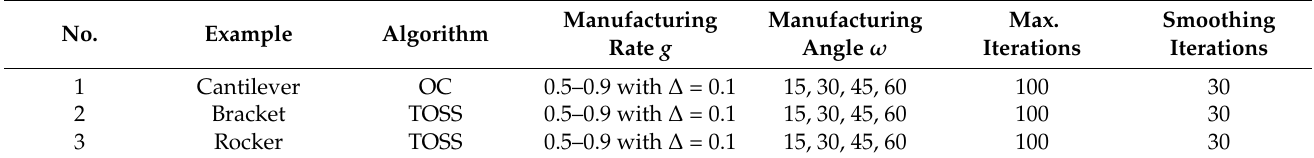
Figure 6. Visualization of the manufacturing, respectively, with printing direction indicated by the green arrow for the cantilever ( a ), the bracket ( b ), and the rocker ( c ) application-examples. We provide a summary of all TO-experiments in Table 1. Table 1. Summary of all TO-experiments for the three application examples, where ∆ defines the step length.